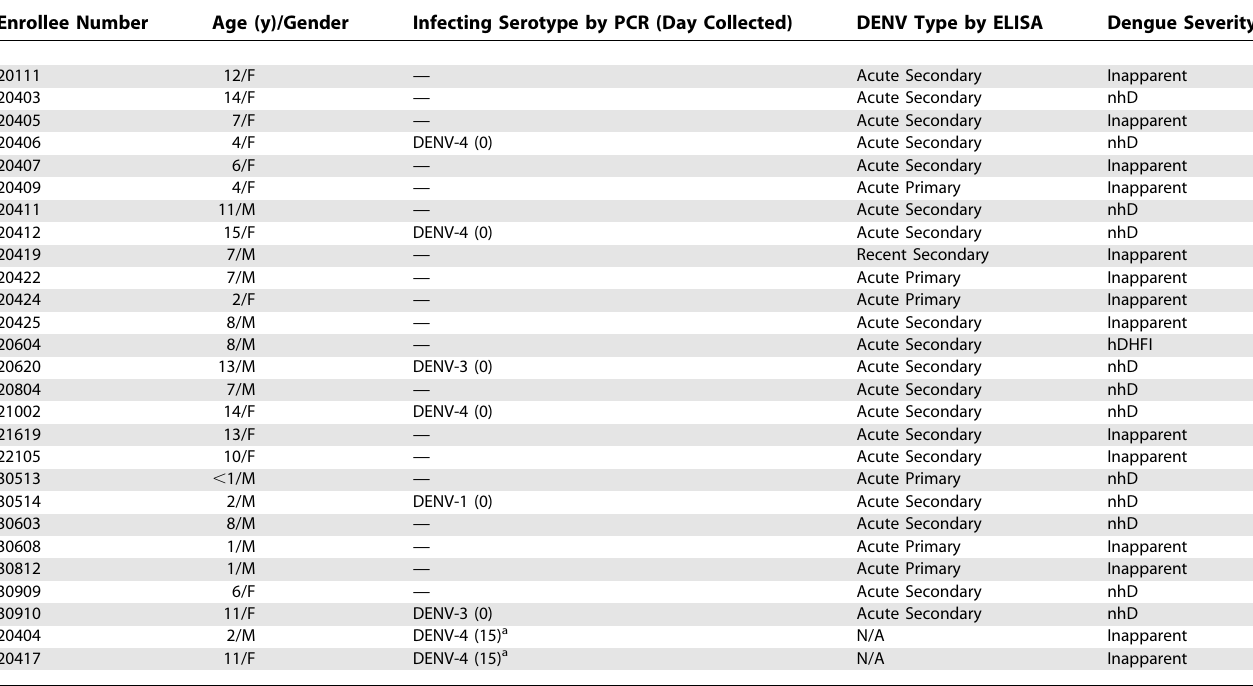
Table 6. Clinical Spectrum of Illness among 27 Enrollees with DENV Infections Enrollee Number Age